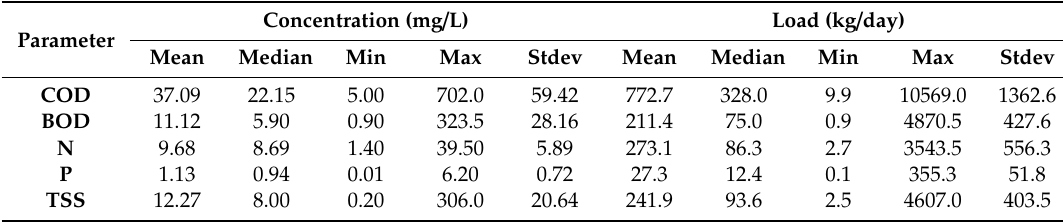
Table 1. Basic statistics of 39 wastewater treatment plants (WWTPs) for 2017 (n = 468). Concentration (mg / Parameter